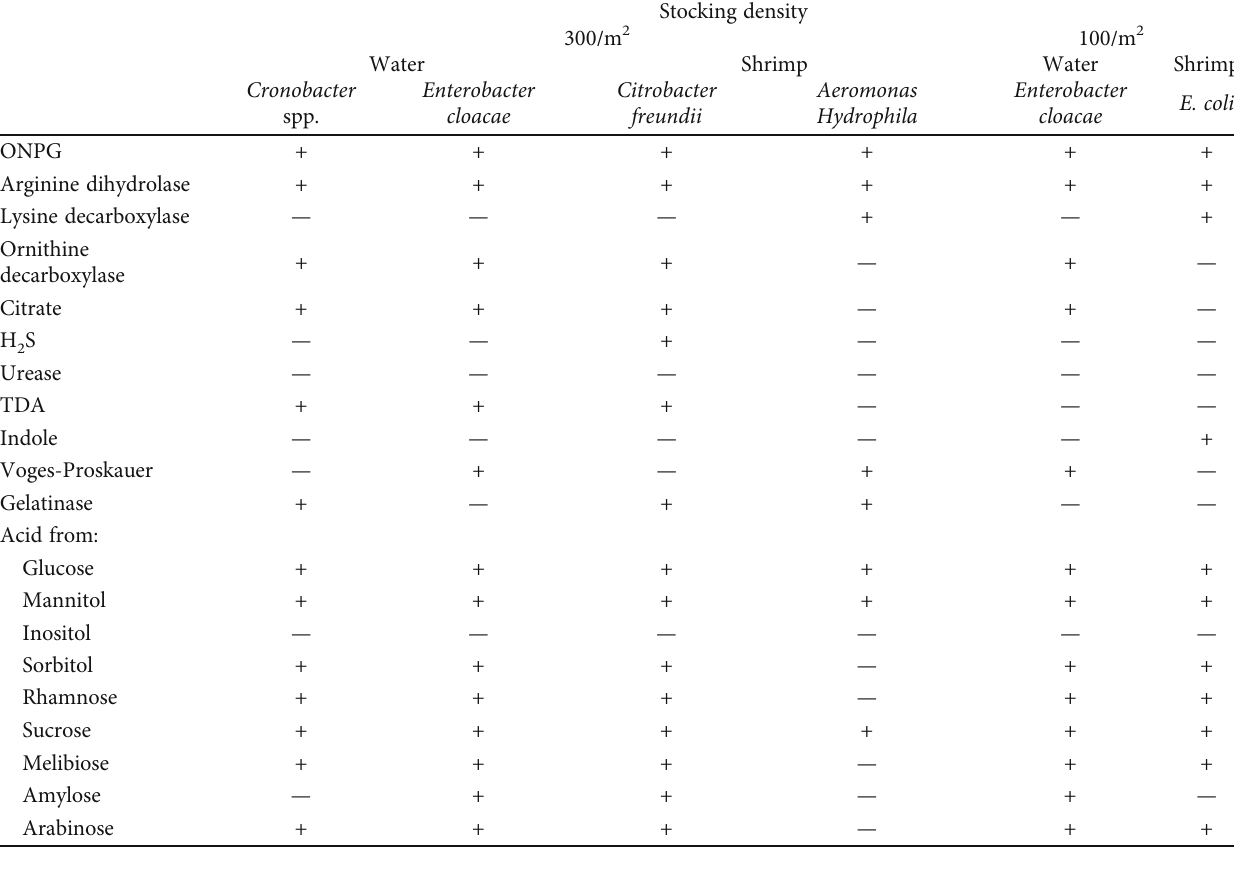
Table 6: Biochemical test results of di ff erent isolated bacteria using API 20E diagnostic strips from shrimp and tanks under bio fl oc system under high (300/m 2 ) and lower (100/m 2 ) stocking density.